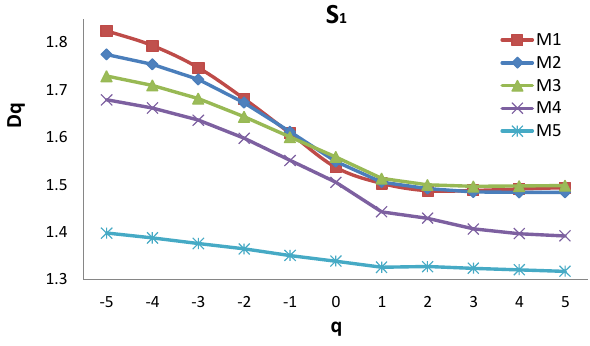
Figure 13. Results of multifractal analysis for sample S 1 . Plots of multifractal dimension D q versus moment q, q є [-5, 5], at magnifications: 12000x (M 1 ), 5600x (M 2 ), 3000x (M 3 ), 1700x (M 4 ) and 800x (M 5 ).